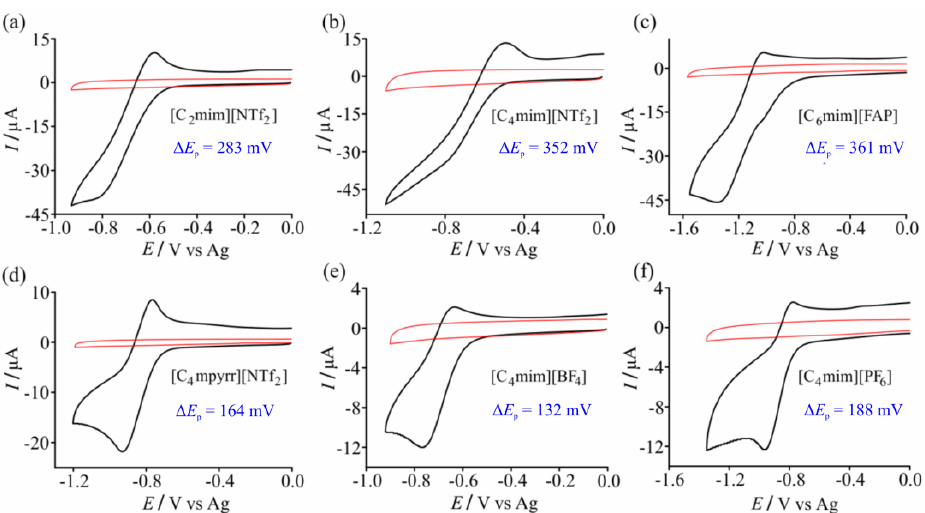
Figure 2. CVs (10 mV · s − 1 ) for the reduction of 100% vol. O 2 on SPGEs in 6 different RTILs: ( a ) [C 2 mim][NTf 2 ], ( b ) [C 4 mim][NTf 2 ], ( c ) [C 6 mim][FAP], ( d ) [C 4 mpyrr][NTf 2 ], ( e ) [C 4 mim][BF 4 ], and ( f ) [C 4 mim][PF 6 ]. The peak-to-peak potentials, ∆ E p , are indicated in blue. Blank CVs (in the absence of oxygen) are shown as red solid lines.